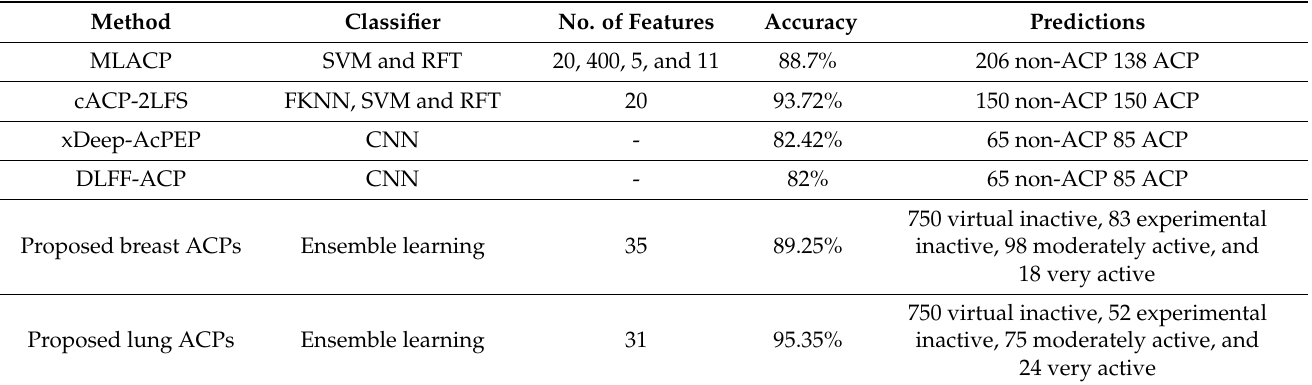
Figure 8. Performance of four classifiers using the lung anticancer peptides. Table 4. Performance comparison with the state of the